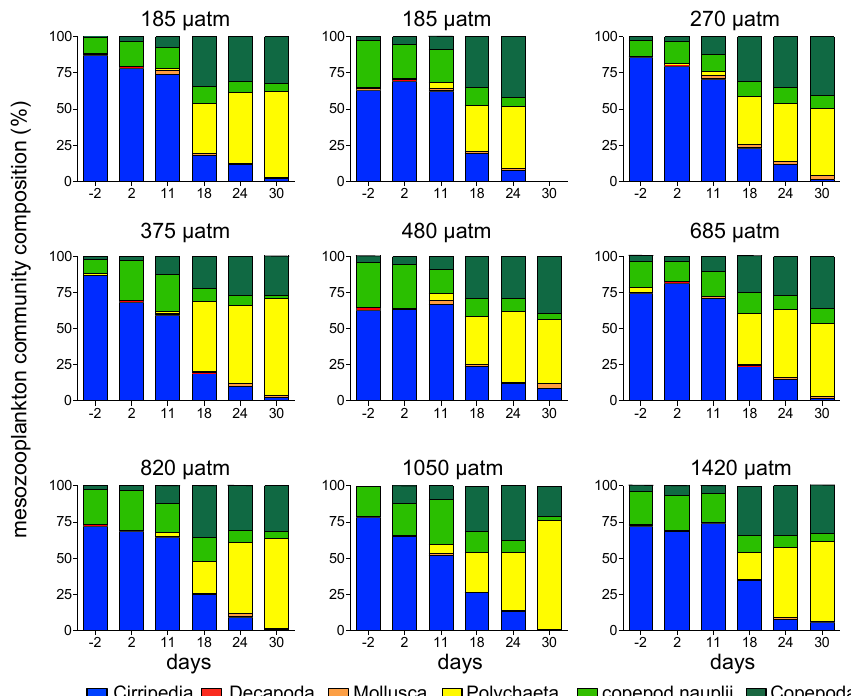
Fig. 3. Mesozooplankton community composition (%) in the water column of nine mesocosms: numbers on top of the panels present the initial CO 2 concentration in each mesocosm after the CO 2 manipulation was completed. At t 30 , no samples were taken in M7 (185µatm) and no data are available. Please, note that “Copepoda” includes both copepodites and adults; copepod nauplii are presented as a different